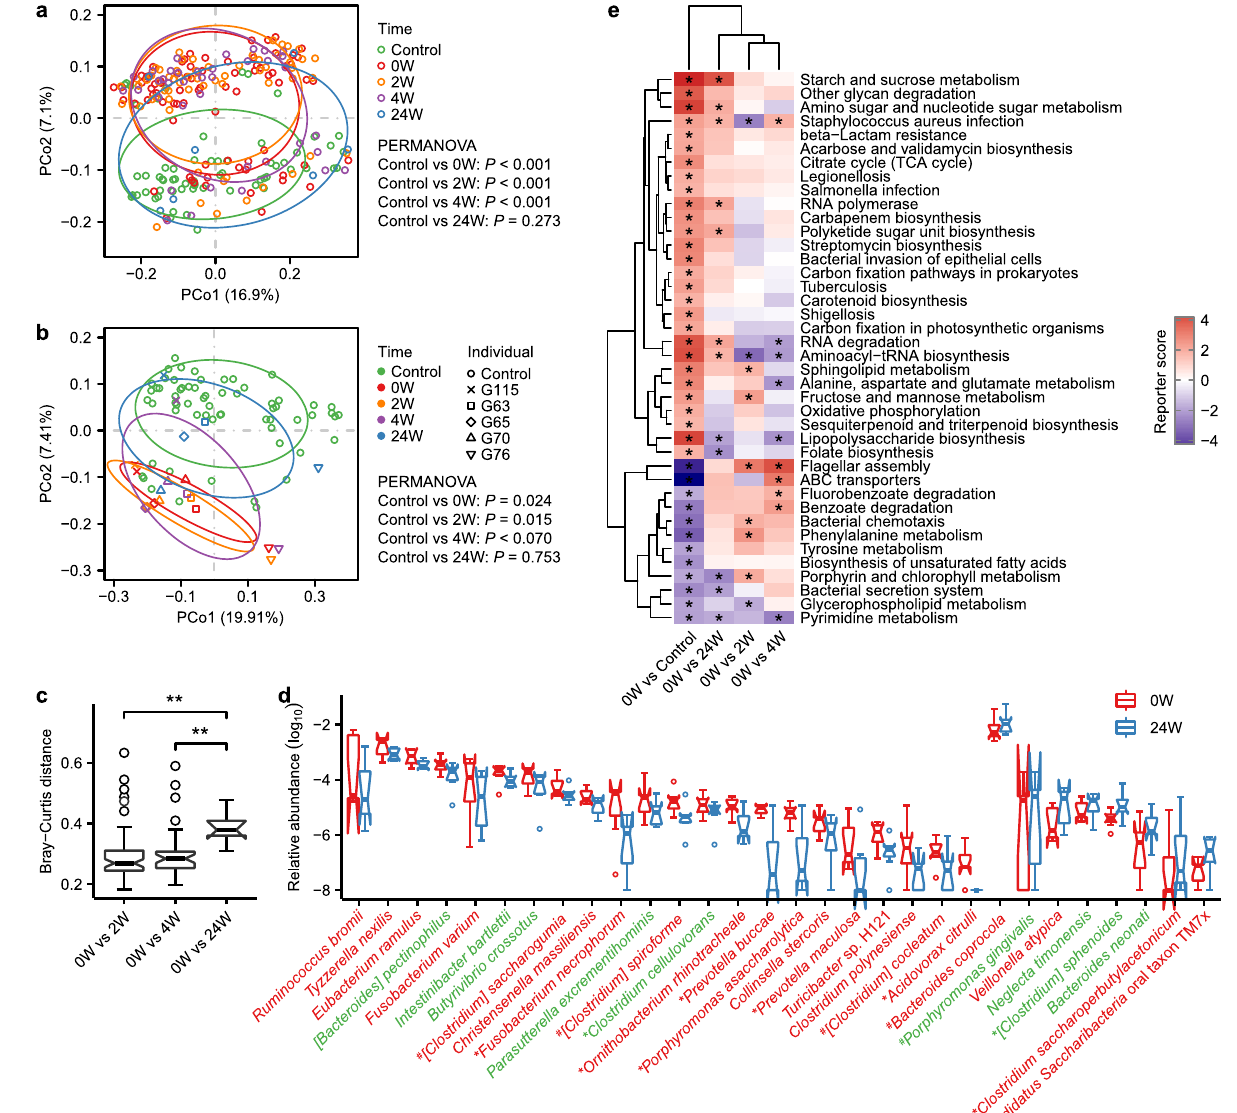
Fig. 5 Alternation of gut microbiota by therapeutic intervention in gout. a PCoA based on Bray – Curtis distance at gene level of healthy controls and gout patients before and after treatment (0W, n = 77; 2W, n = 61; 4W, n = 38; 24W, n = 7). The 95% con fi dence ellipses were shown for all subgroups. b PCoA based on Bray – Curtis distance at gene level of healthy controls and fi ve time point paired gout patients. The 95% con fi dence ellipses were shown for all subgroups. c Box and whisker plot of beta diversity of gout patients between before and after treatment. Wilcoxon rank-sum test: Double asterisks denote P < 0.01. d The relative abundance of bacterial species was modulated after 24 weeks treatment ( P < 0.05, paired Wilcoxon rank-sum test, n = 7). Bacterial species in color green and red indicate healthy control-enriched and gout patient-enriched in discovery cohort, respectively. e Microbial gene functions were changed after treatment. Purple, enriched in healthy controls or patients after treatment; red, enriched in patients before treatment. Asterisk denotes reporter score of pathways > 1.65 or < − 1.65. For all box and whisker plots, the center line represents median. The bounds of box represent the fi rst and third quartiles. The upper whisker extends from the hinge to the largest value no further than 1.5 * interquartile range (IQR) from the hinge. The lower whisker extends from the hinge to the smallest value at most 1.5 * IQR of the hinge. The notch represents a con fi dence interval around the median as the median ± 1.58*IQR/sqrt( n